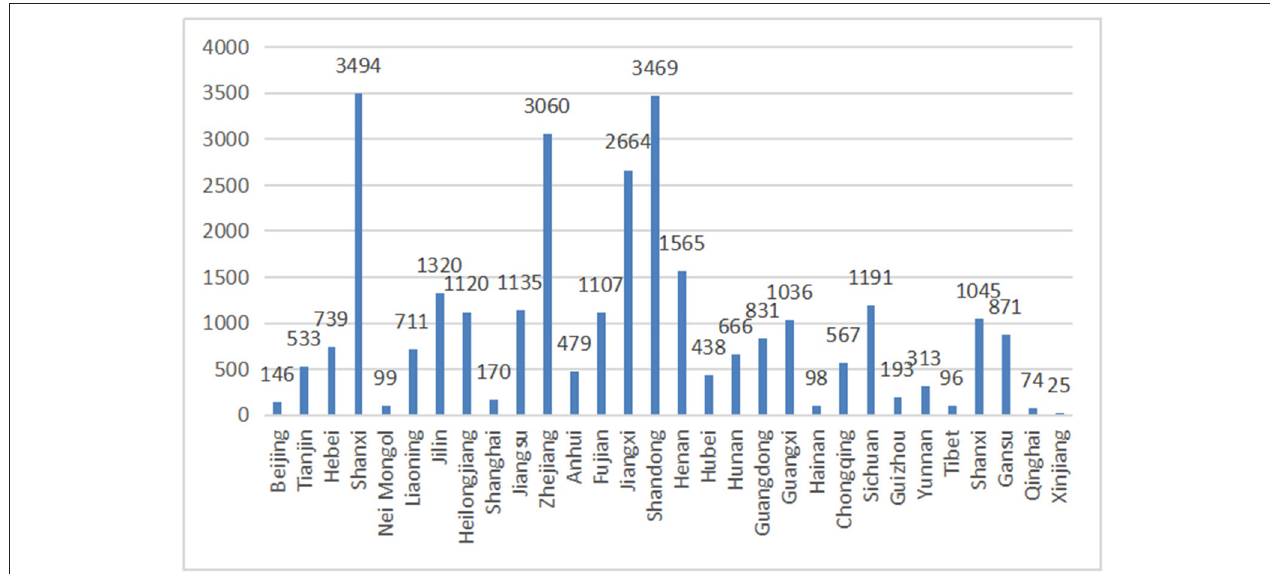
FIGURE 2 | Distribution map of provinces where the sample schools are